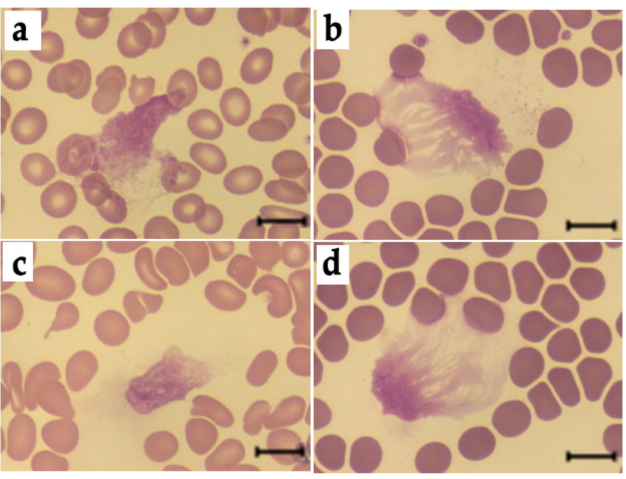
Figure 11. Typical examples of NET-like structures in blood smears in the presence of HSA ( a , b ) and HSA-MG ( c , d ), before ( a , c ) or after ( b , d ) the action of PMA for 2 h. Scale bar: 10 µ